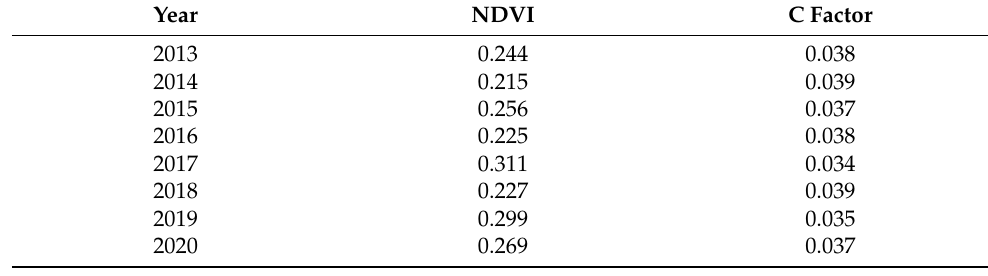
Figure 3. Map of the K factor values across the watershed.